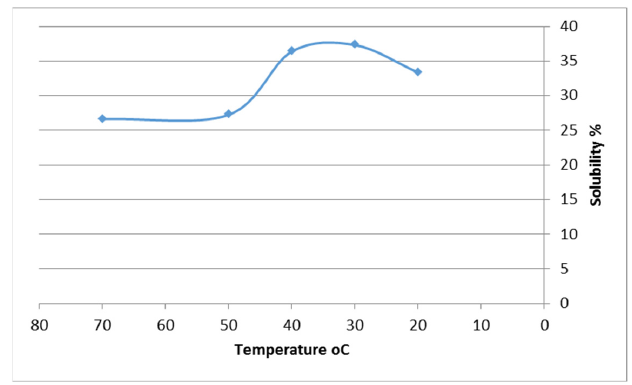
Figure 2. Solubility (%) versus temperature (with concentration of Oxalic acid 4%).